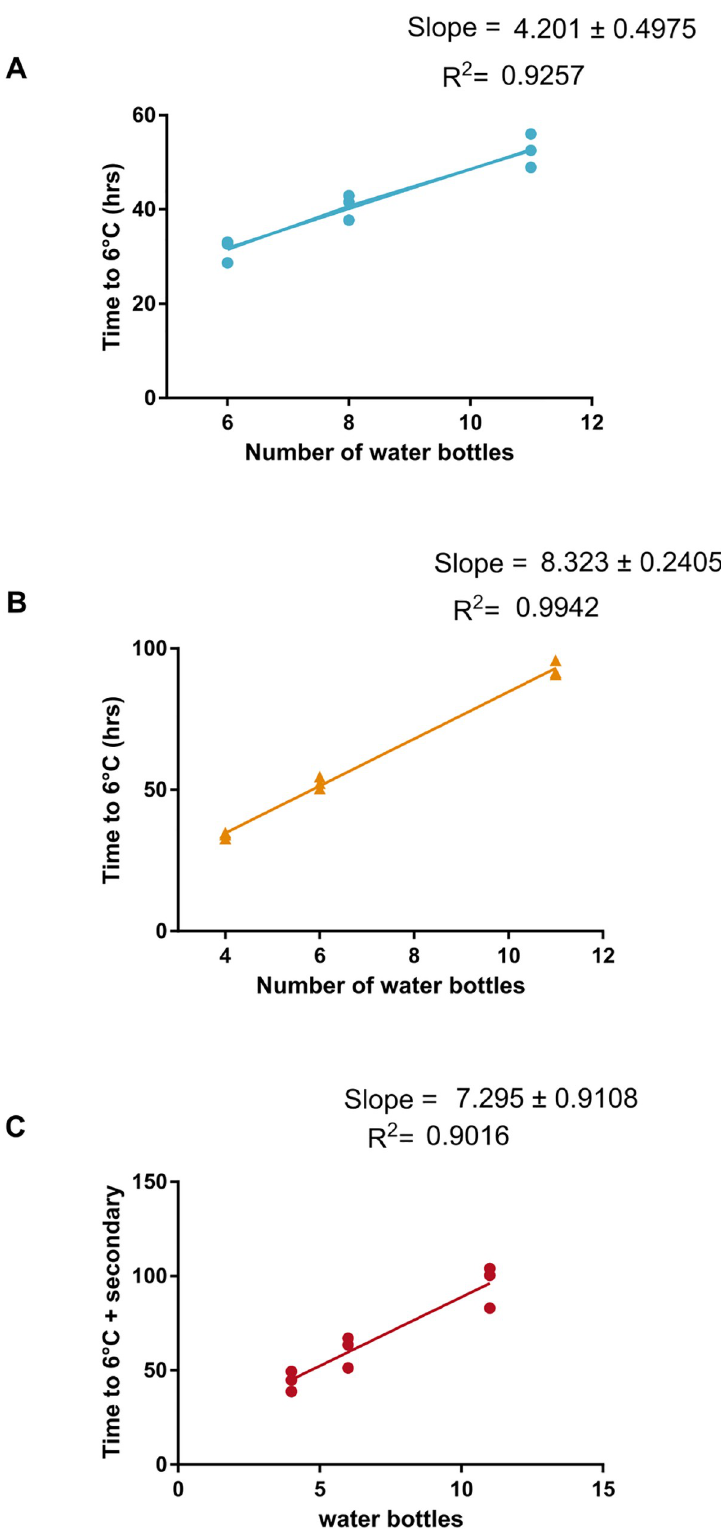
Fig 4. Modeling cold time as a function of the amount coolant. Cold time was plotted as a function the amount of frozen water bottles and a linear function was fitted in (A) Injection molded coolers, (B) rotomolded coolers, and (C) PS foam coolers (n = 3 for all coolers). The R 2 was calculated for each set of coolers. https://doi.org/10.1371/journal.pone.0231093.g004 PLOS ONE | https://doi.org/10.1371/journal.pone.0231093 April 17,